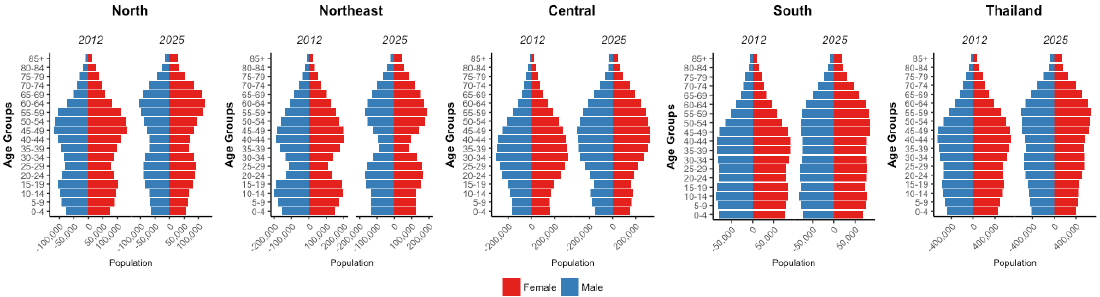
Figure 2. Population distribution for each region and nationally in 2012 and the expected population distribution in